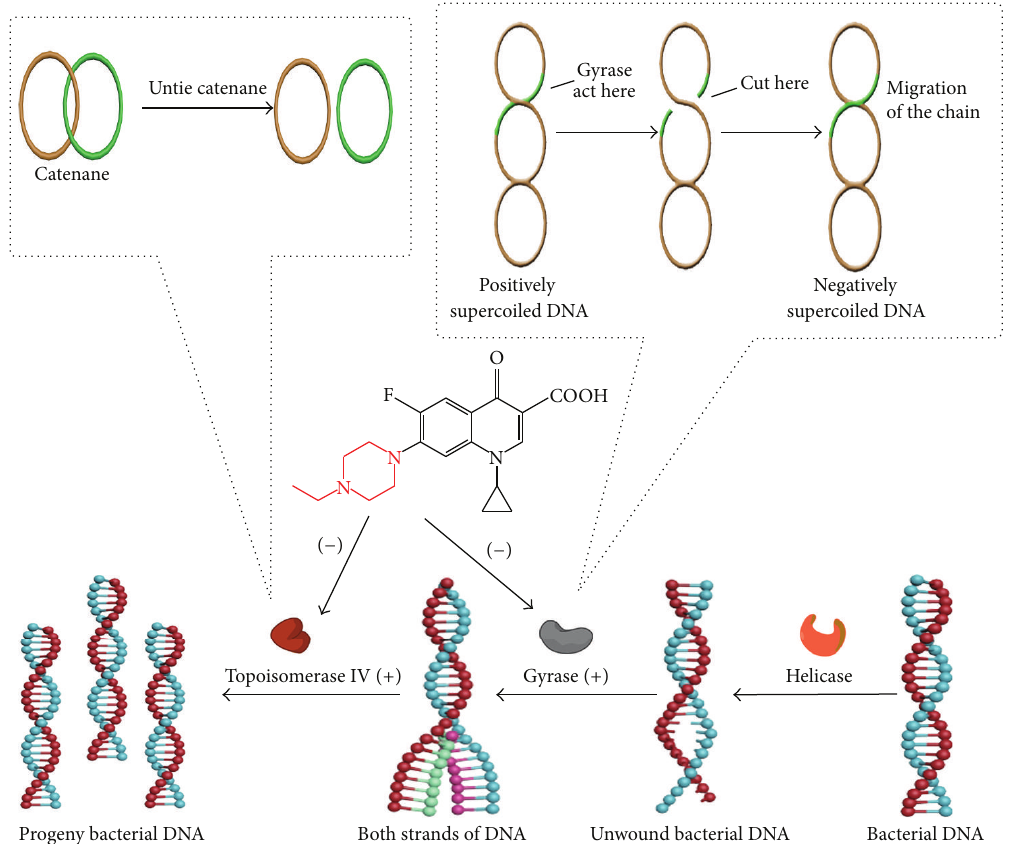
Figure 4: Schematic representation of mechanism of action of enrofloxacin with bacterial